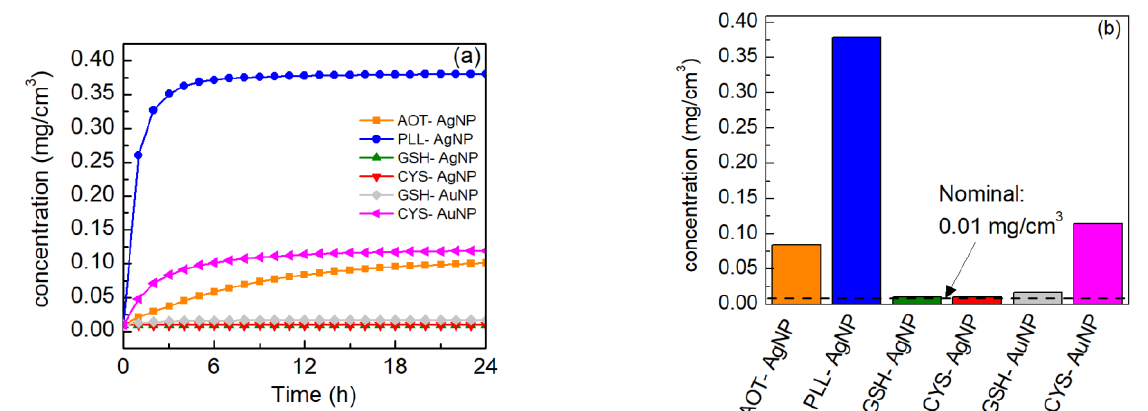
Figure 4. Calculated values of different NPs with the same nominal concentration (0.01 mg/cm 3 ) deposited per surface area of a 96-well plate. ( a ) Evolution of sedimentation of different NPs at the bottom of the wells of the cell culture plates expressed as mass concentration, and ( b ) the median value of the amount of NPs that reached the bottom compartment of the assay plates for 1 h time interval expressed as mass concentration.